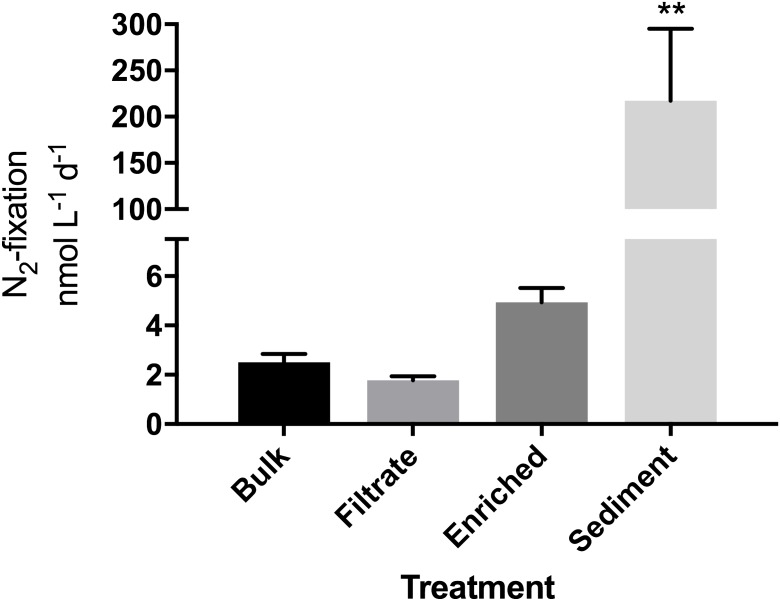
N2-fixation rates in the particle enrichment experiment measured in quadruplicate incubations. Due to a sample loss, an average of T0 values from the filtrate and enriched samples (N = 8) was used as the T0 value for the bulk sample. ∗∗Significantly different from all other (Tukey’s; p = 0.001).